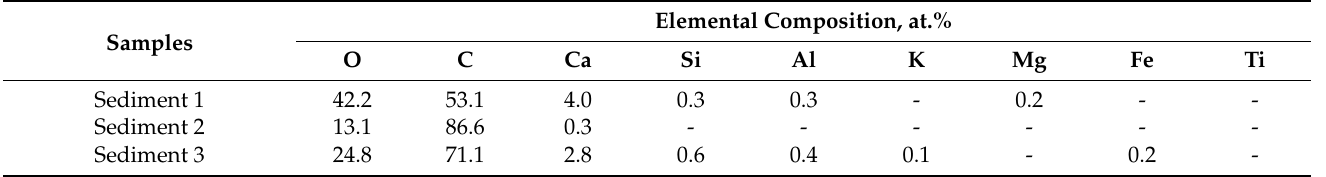
Table 3. Elemental compositions of the organic fractions within amphora sediments. Elemental Composition, Samples